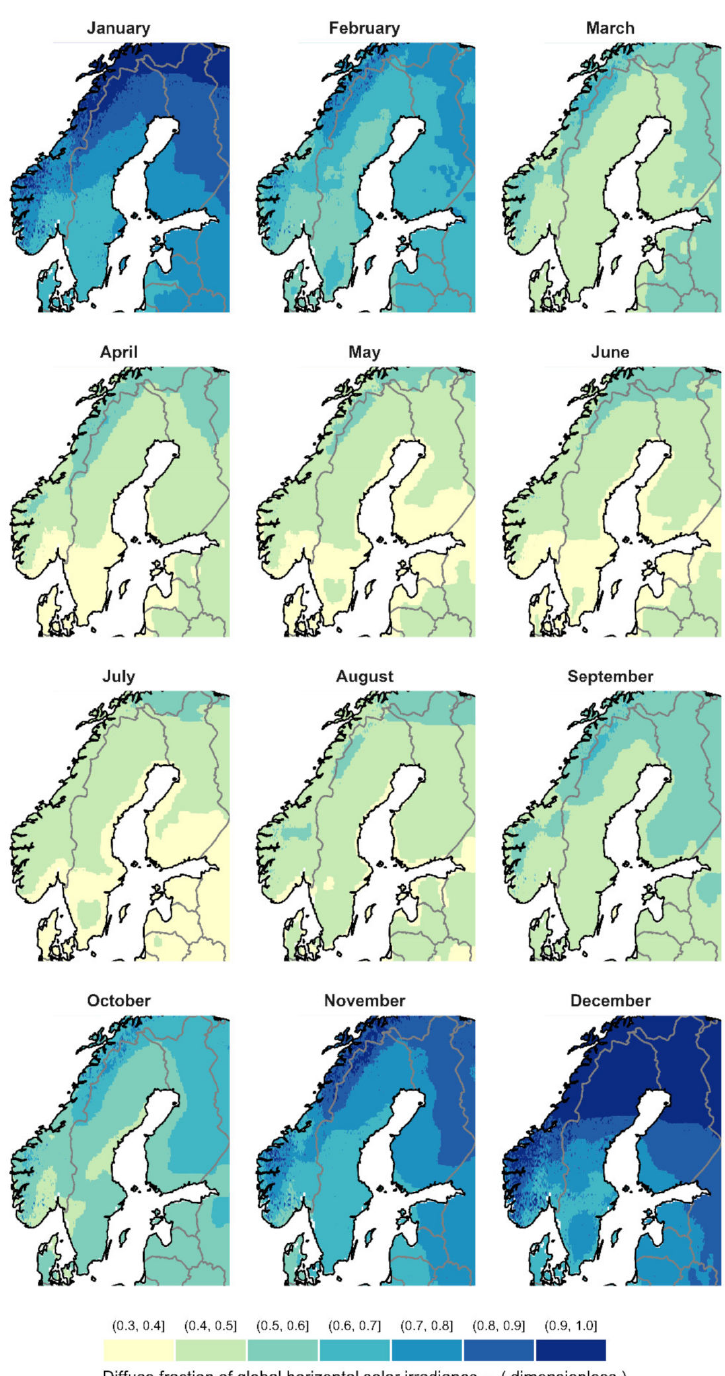
Figure 4. Monthly average diffuse fraction of global horizontal irradiance (G d /G h ) for the Nordic and Baltic countries. Values from the ECMWF-ERA-5 dataset with a coverage period of 2005–2016 retrieved from PVGIS as a 0.1 ◦ × 0.1 ◦ grid both in latitude and longitude, extending from 54.5 ◦ N to 70 ◦ N in latitude and 4.5 ◦ E to 31.5 ◦ E in